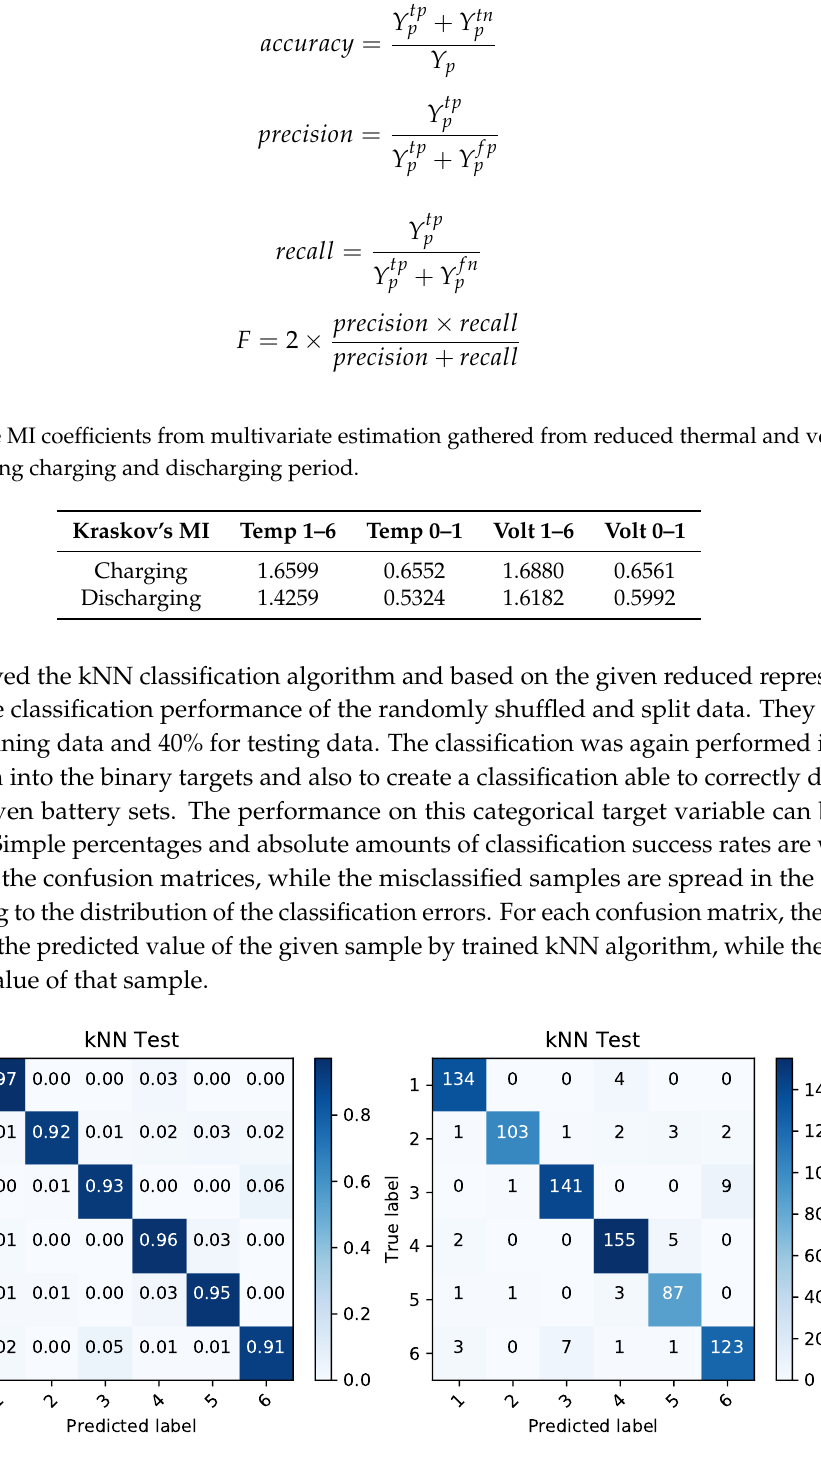
Figure 12. Confusion matrices produced by kNN prediction based on temperature data during charging period. The matrix of percentages between correctly and incorrectly classified samples ( left ) is accompanied by a confusion matrix covering the absolute values of the same classified samples ( right